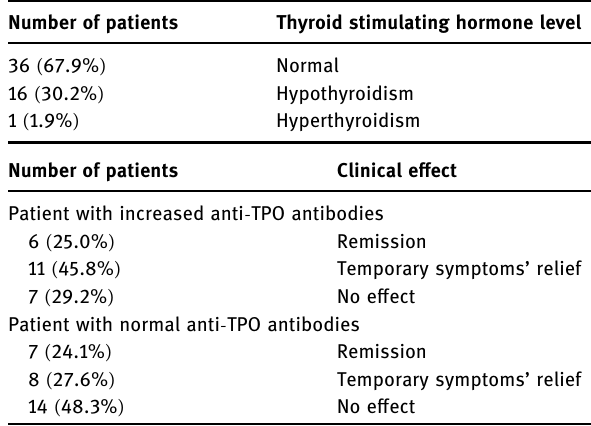
Figure 2: Number of plasmapheresis courses.